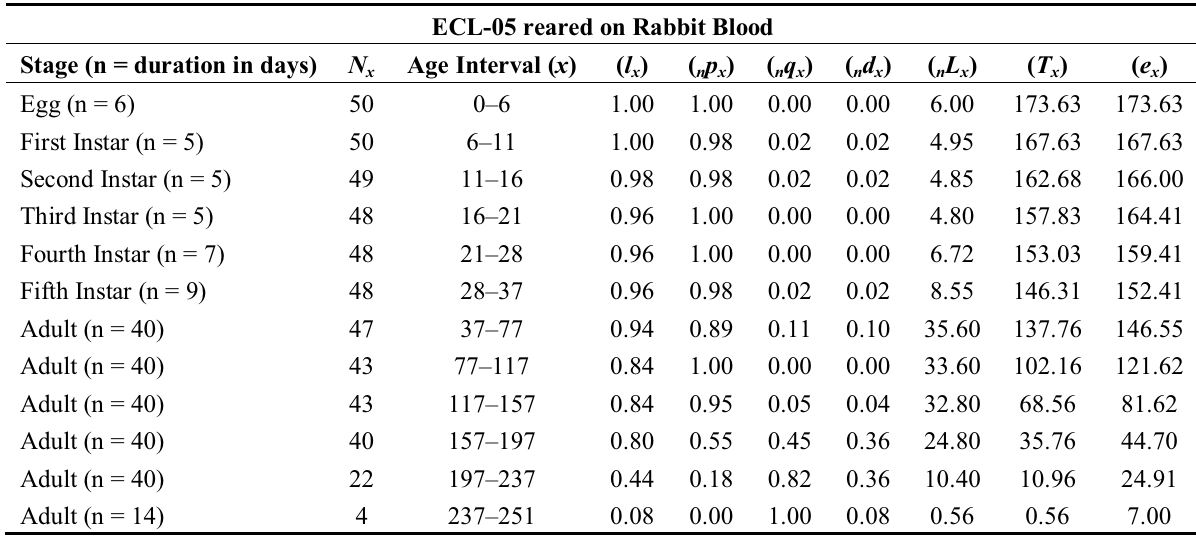
Table 5. Stage specific life table of ECL-05 strain Cimex lectularius on rabbit blood. ECL-05 reared on Rabbit Blood